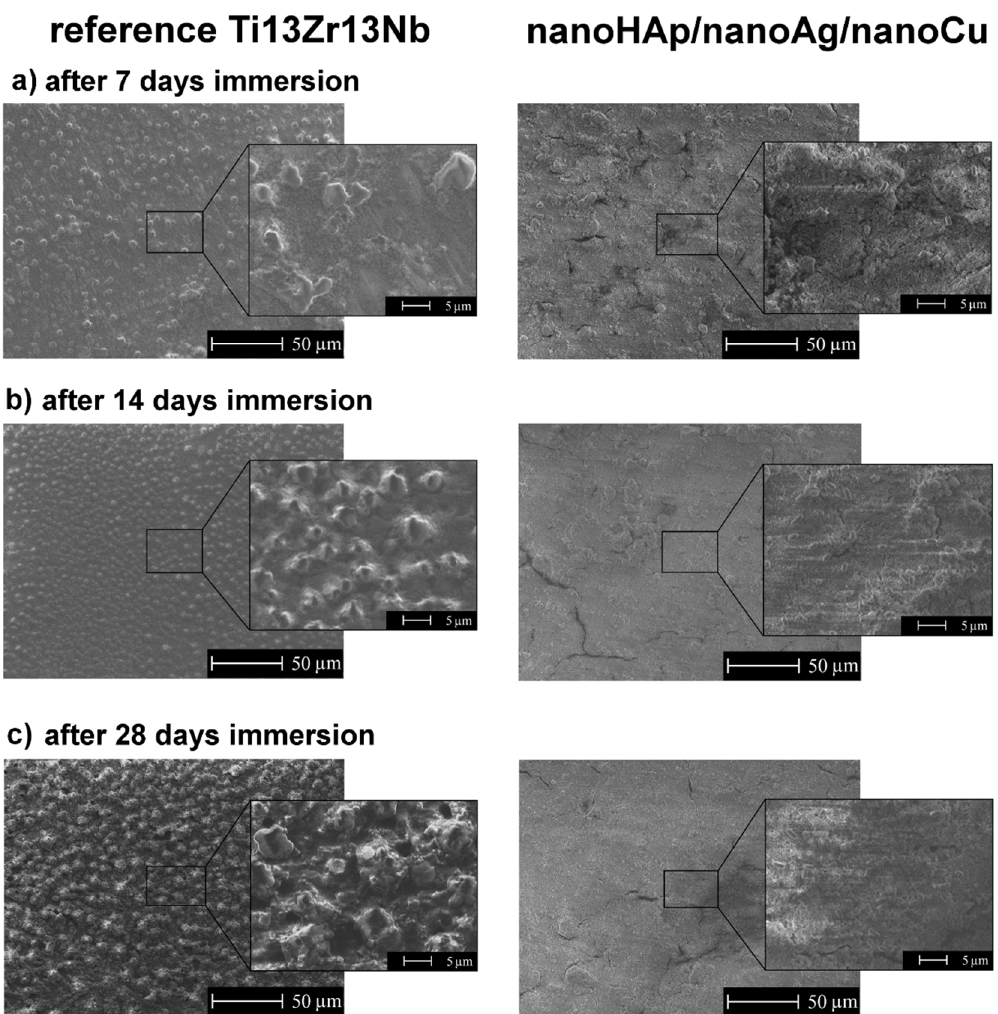
Figure 4. SEM images of the surfaces of reference Ti13Zr13Nb specimens (left column) and nanoHAp/nanoAg/nanoCu coatings (right column) after: ( a ) 7, ( b ) 14 and ( c ) 28 days of exposure in the bacteria solution.